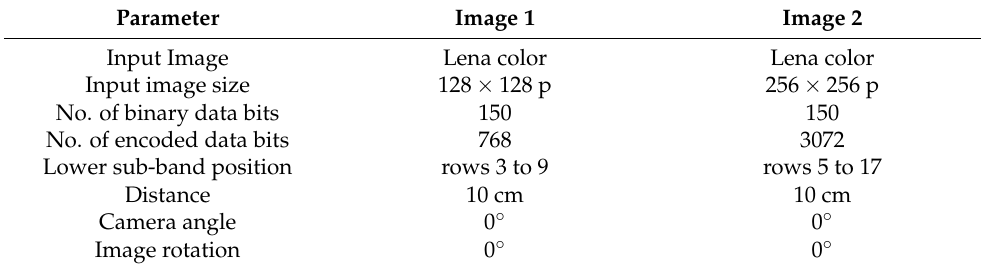
Table 5. Experimental parameters for image quality